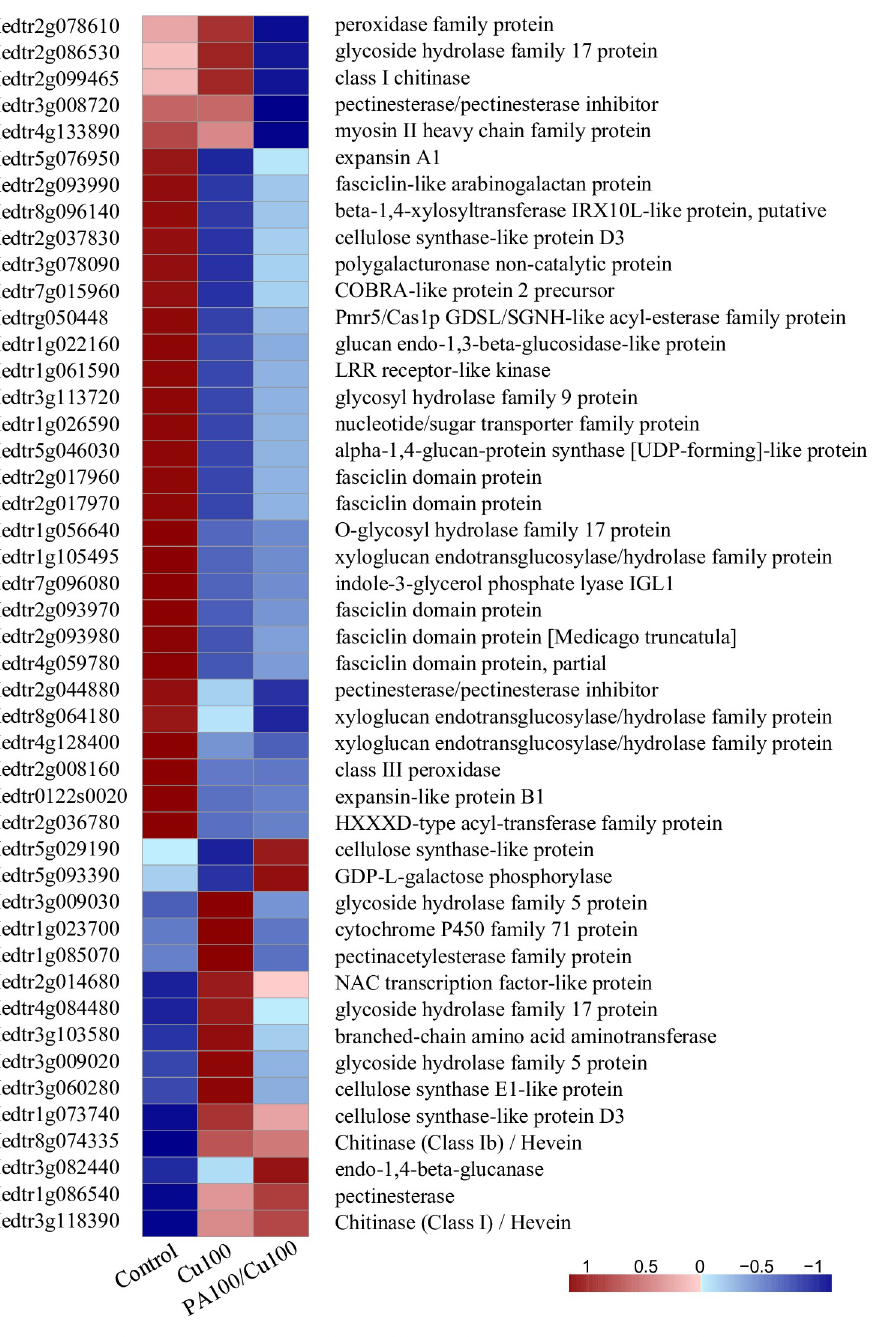
Fig 6. Heatmap shows the expression profile of differentially expressed genes in the cell wall and represents Z- scores of transcripts per million (TPM) for each gene. PA100: 100 mg L -1 PAs pretreatment, Cu100: 100 mg L -1 CuSO 4 •5H 2 O. appeared to up-regulate the synthesis of a crucial anti-oxidant, AsA, which, as shown above, can ameliorate the toxic effects of Cu toxicity (Fig 3). Also, endo-1,4-beta-glucanase (MTR_3g0822440), which plays a key role in cell wall synthesis and growth, exhibited notable up-regulation. The increase here after PAs and Cu treatment, compared to both untreated and